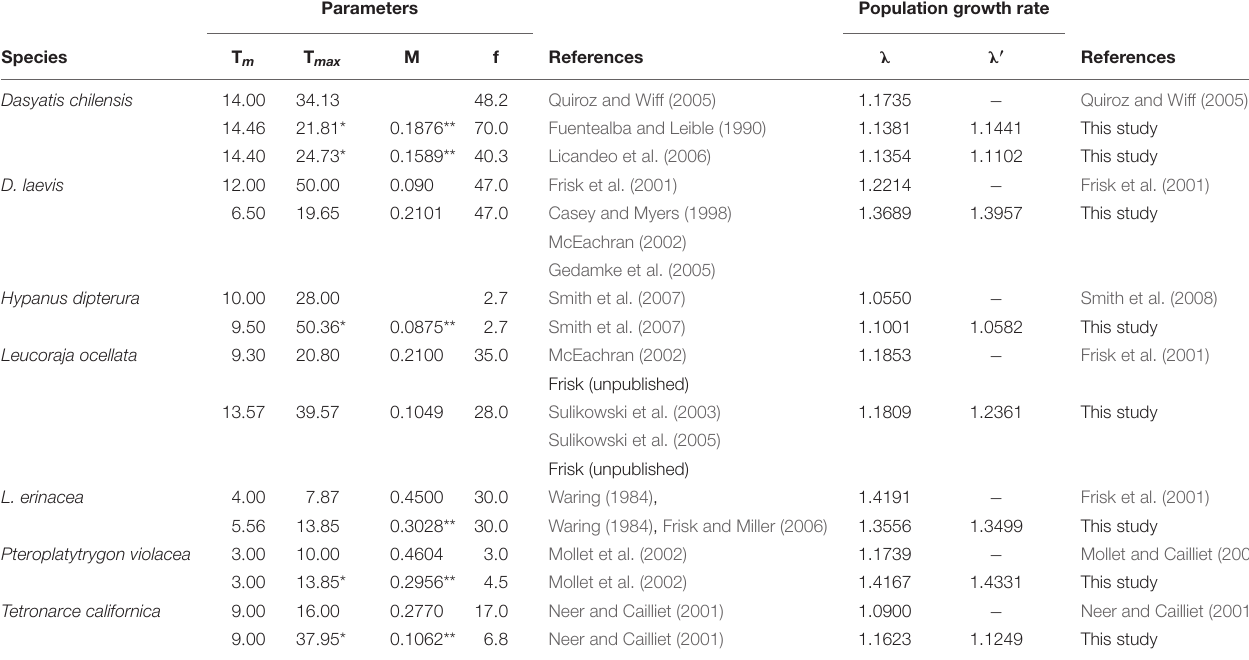
TABLE 4 | Comparison of finite rate of population increase( λ )for 7 species of skates and rays from different studies.